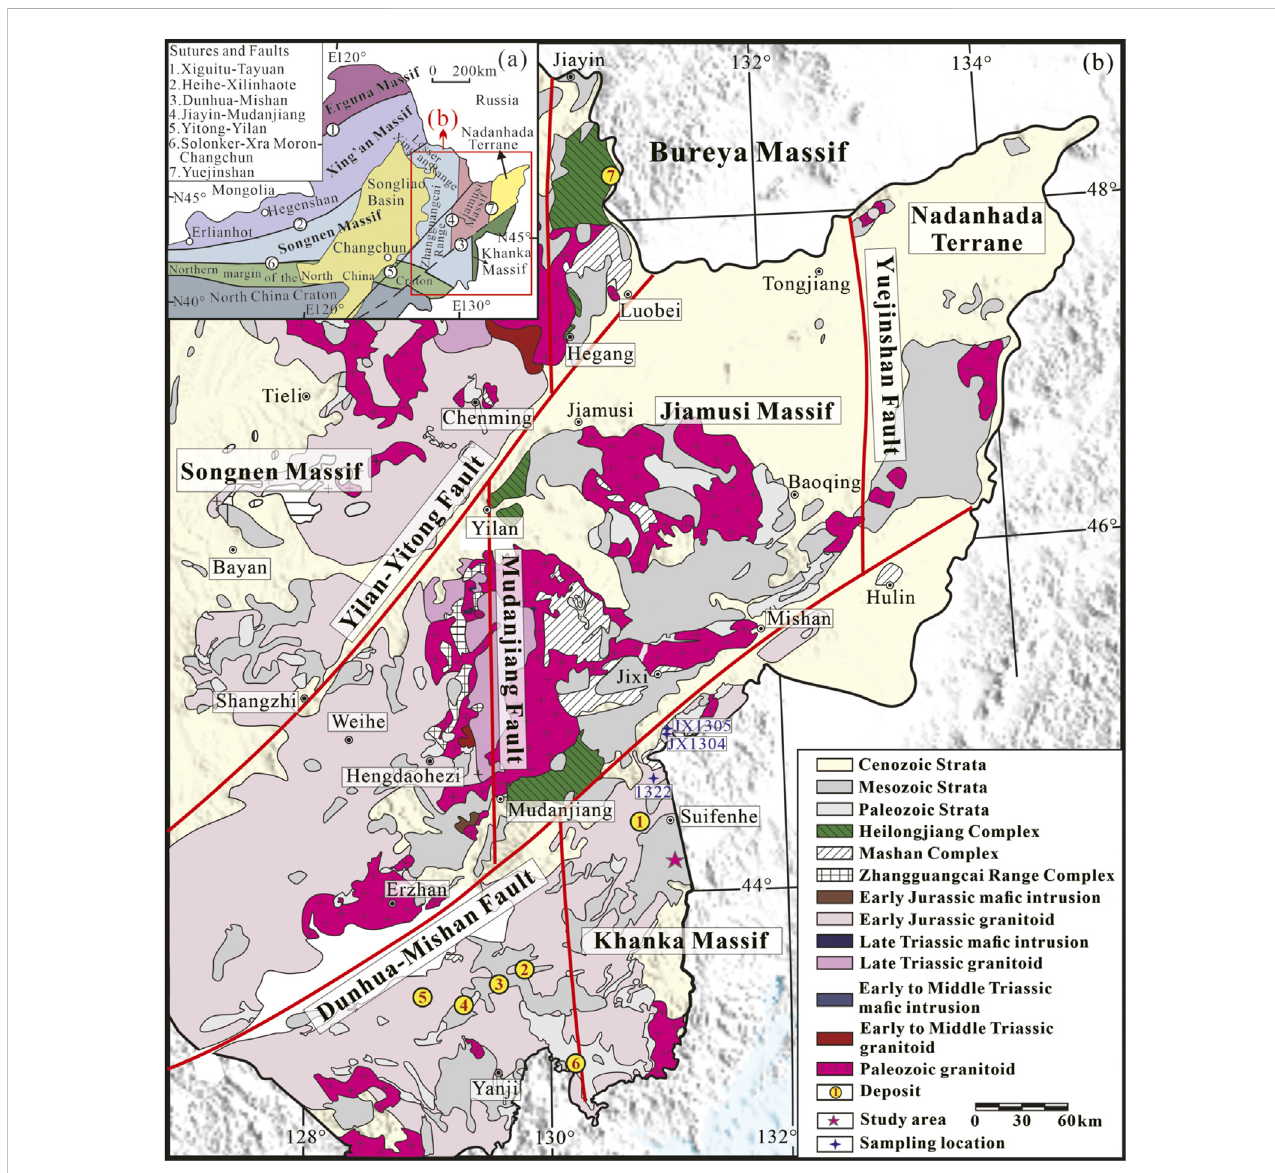
FIGURE 1 TectonicsketchmapofNEChina (A) (modi fi edfromXuetal.,2019);PolymetallicdepositsintheXinchenggouarea (B) (modi fi edfromZhangetal.,2008; Long et al.,